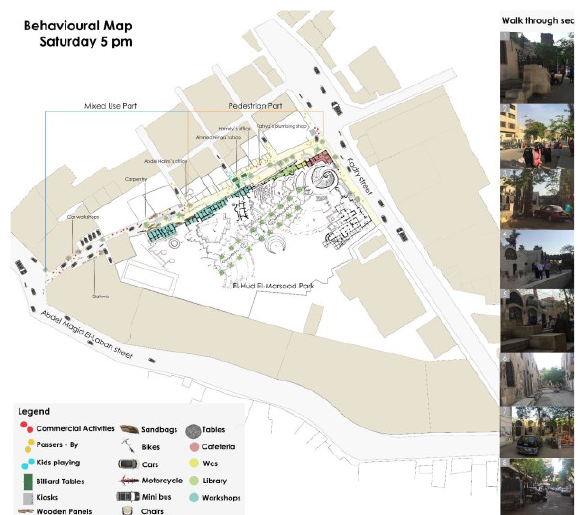
Figure 7 : Behavioral Mapping of the Park and Street, BTU- Cottbus Double Msc Degree Students, 2017.